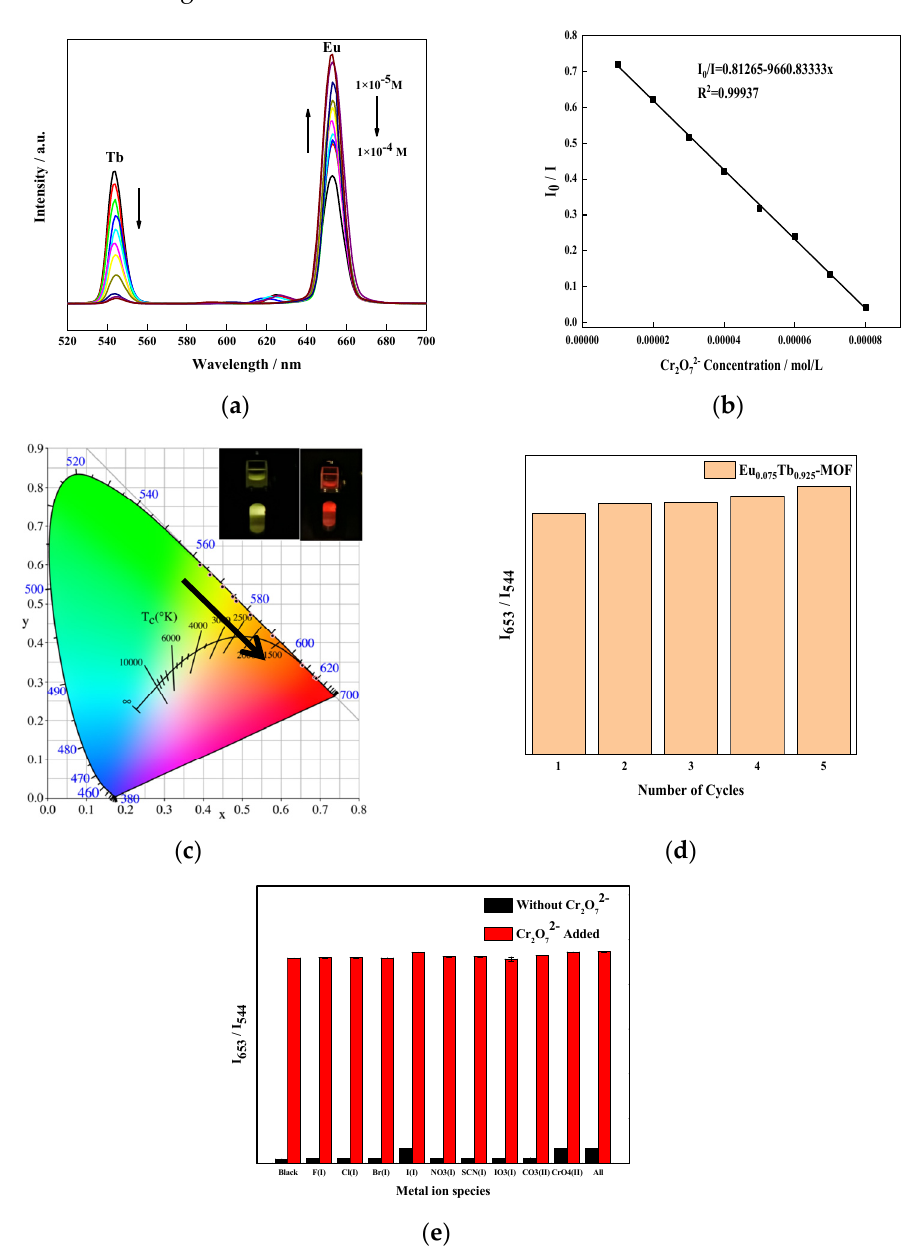
Figure 9. ( a ) The emission spectra of Eu 0.075 Tb 0.925 -MOF dispersions with different Cr 2 O 72 − concen- trations under 310 nm excitation light. ( b ) Calibration line with Cr 2 O 72 − (in the range of 10–100 μ M/L), ( c ) CIE, ( d ) cycles of Eu 0.075 Tb 0.925 -MOF, and ( e ) I Eu /I Tb histogram of Eu 0.075 Tb 0.925 -MOF dis- persion containing anions.